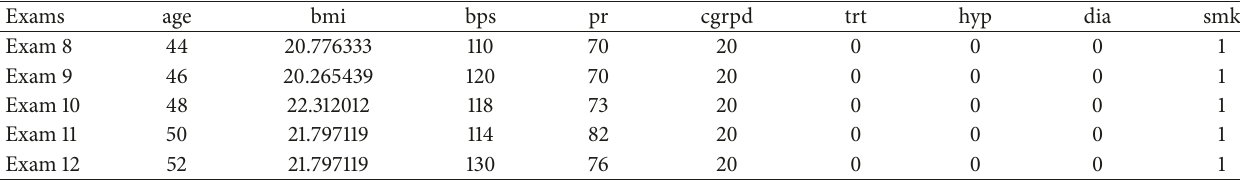
Table 10: Exam data for Sample 3: female without CVD.